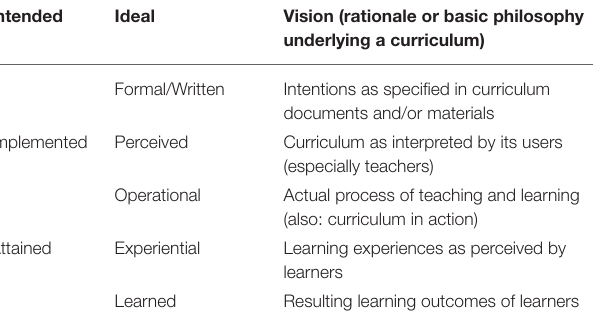
TABLE 1 | Typology of curriculum representations ( van den Akker,